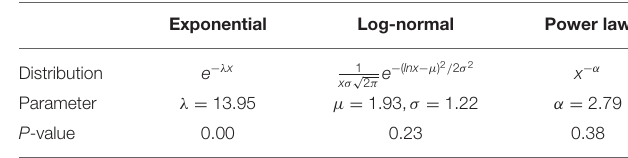
TABLE 1 | The results of goodness-of-fit for degree